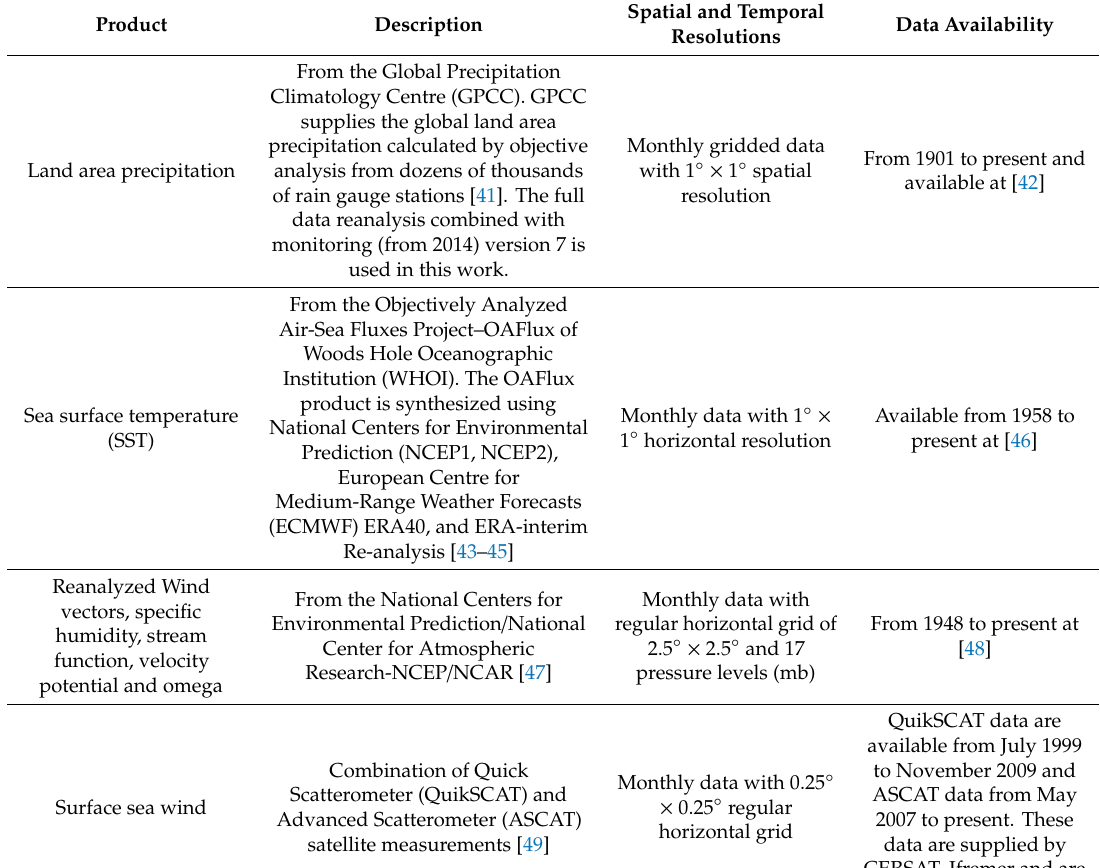
Table 1. Information about the di ff erent products used in this